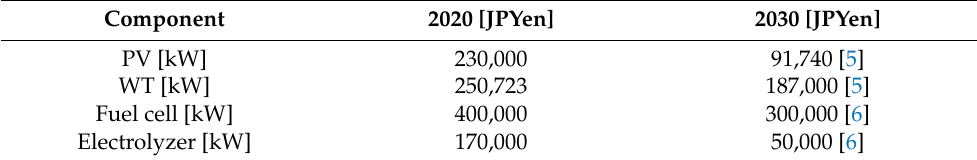
Table 12. Summary of current and future initial capital costs in the future cost scenario.